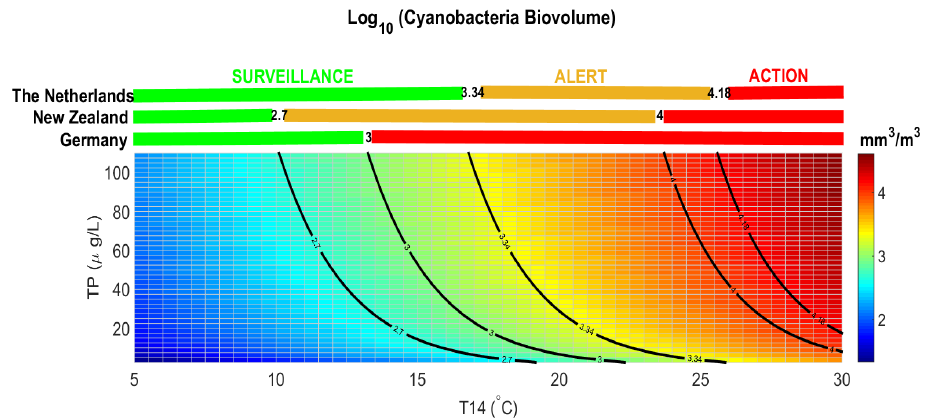
Figure 7. Estimated cyanobacteria biovolume calculated for Lake Varese using model No.2 of Table 3. The colored field represents LOG CyanoBV at different levels of the two predictors, T14 ranging between 5 and 30 °C, and TP ranging between 2.5 and 110 µg/L. The colored bars above the plot and the black lines refers to examples of threshold levels for cyanobacteria biovolume (surveillance in green, alert in orange, and action in red) of defined by legislation in The Netherlands, New Zealand, and Germany.